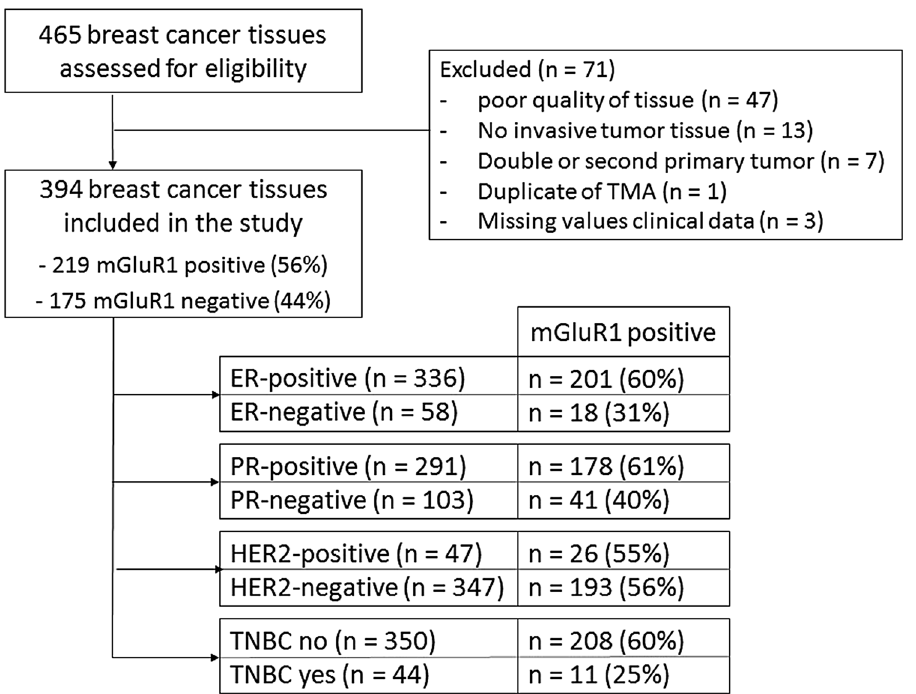
Figure 1. Flowchart of primary breast cancer tissues included in this